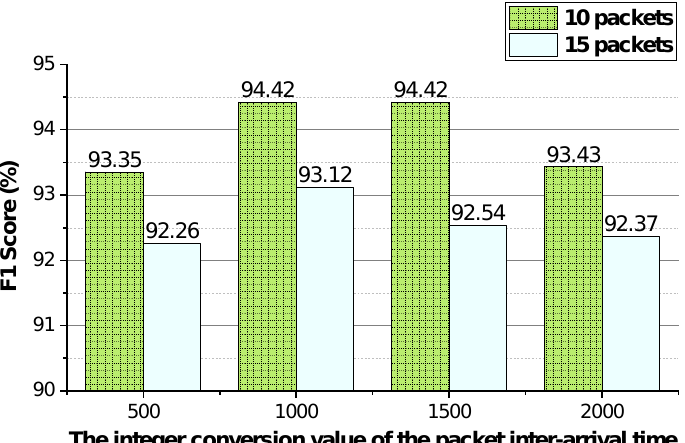
Figure 5. The Shadowsocks traffic detection performance of the method using different integer conversion values of packet inter-arrival